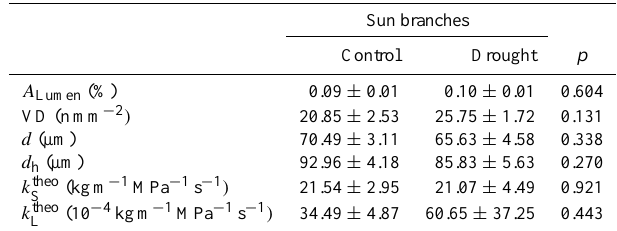
Table 5. Isotope signatures of carbon ( δ 13 C) and oxygen ( δ 18 O) in leaf biomass and foliar contents of C, N, P and cations per mass and per leaf area in leaves that were harvested distal to the branch segments used for hydraulic measurements. Mean nutrient concen- trations ( ± 1SE, n = 7) in gkg − 1 or gm − 2 . For the level of signifi- cance ( p ) of treatment differences see Table A5 in the